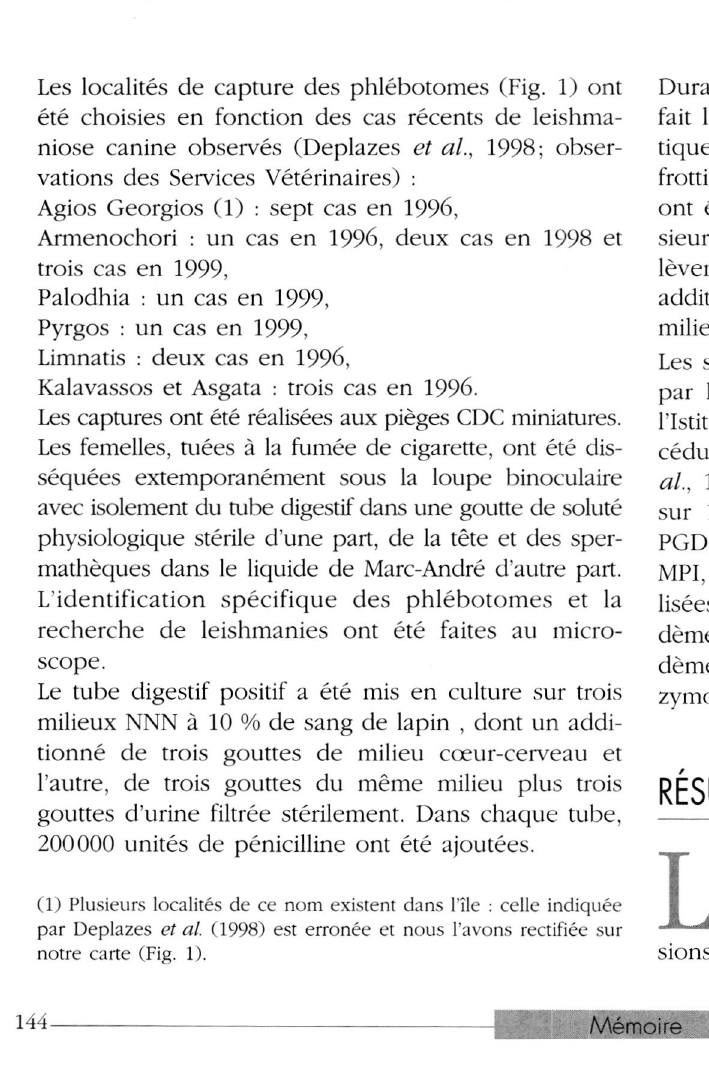
Fig. 1. - Carte illustrant les localités de capture des phlébotomes et les localités de prélèvement des chiens leishmaniens. (• : station de capture des phlébotomes; © : station de capture du phlébotome infesté; • : station de prélèvement d'un chien leishmanien).